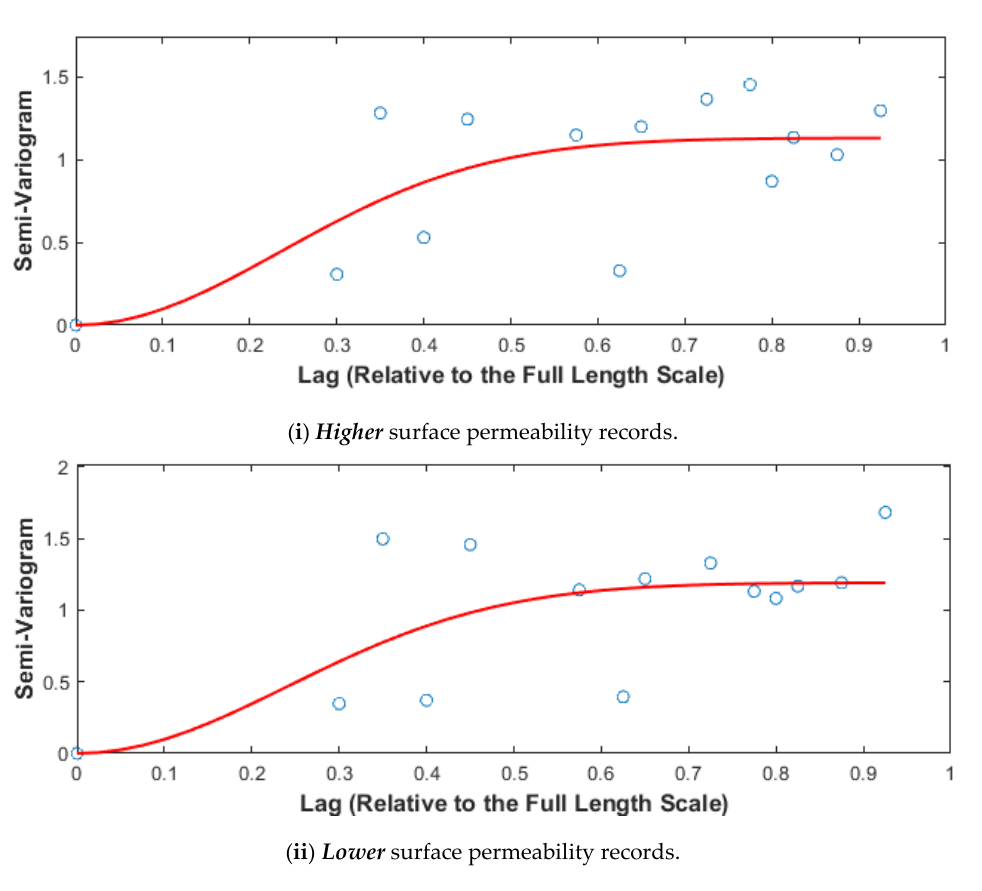
Figure 11. Semi-variograms for the kriging procedure of Stanstead granite.